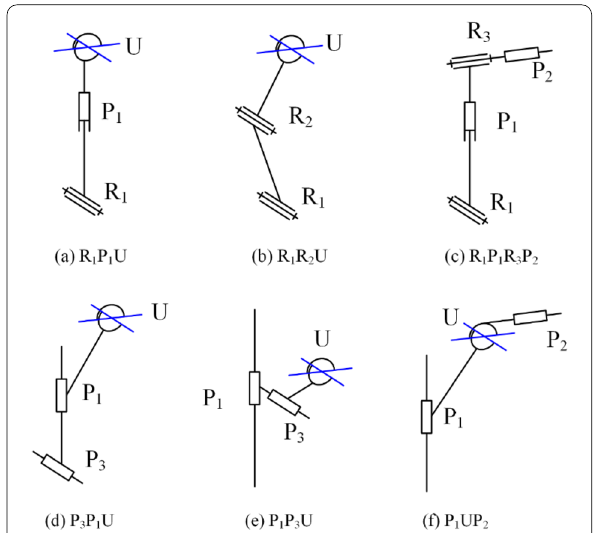
Figure 5 Six types with four single joints in Case 2